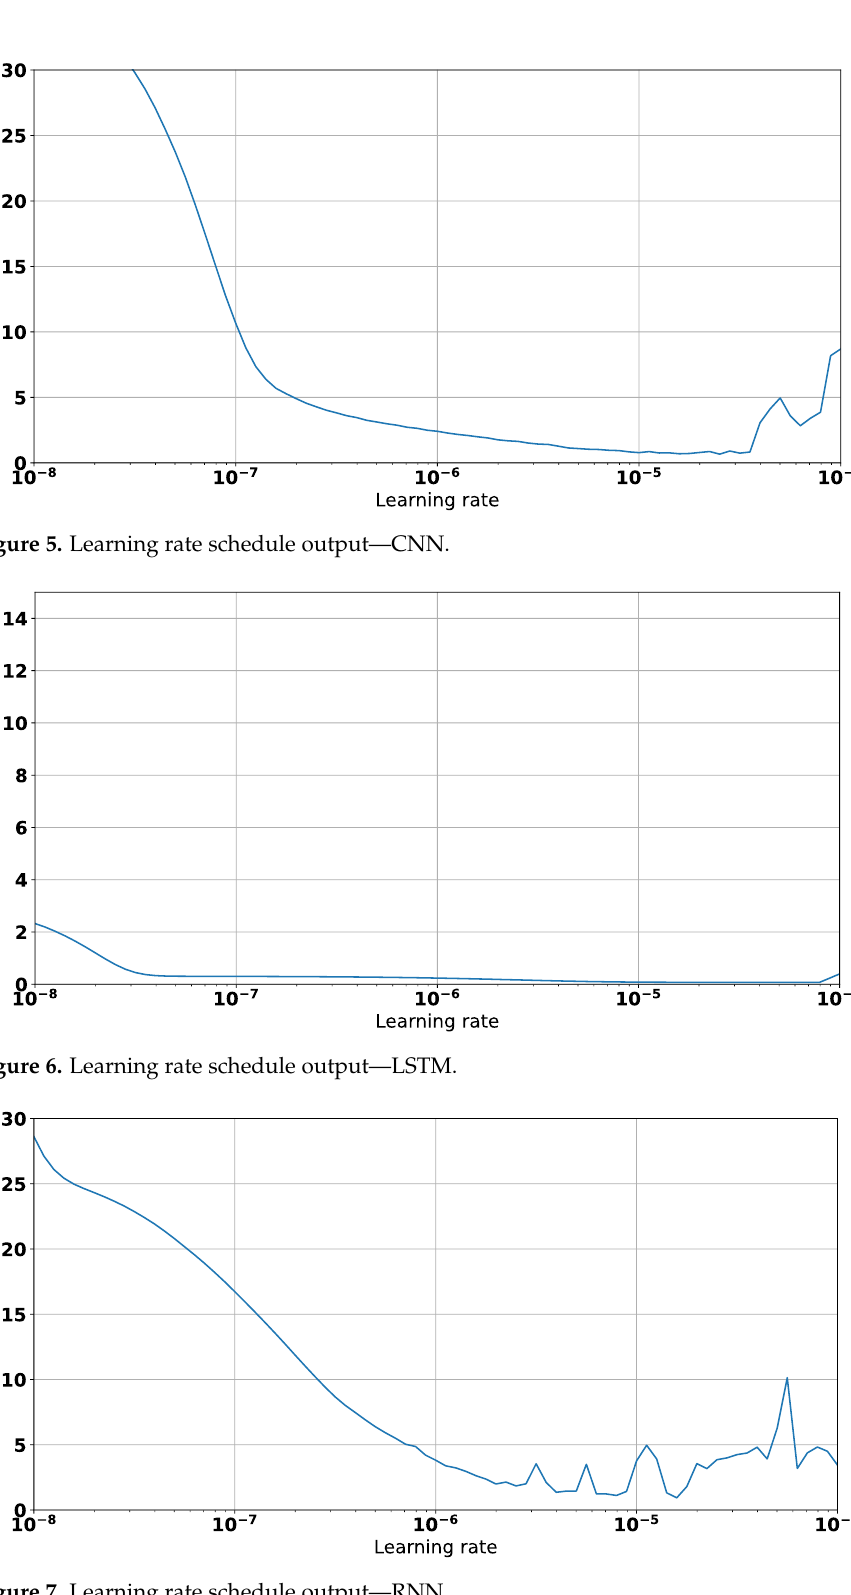
Figure 7. Learning rate schedule output - RNN